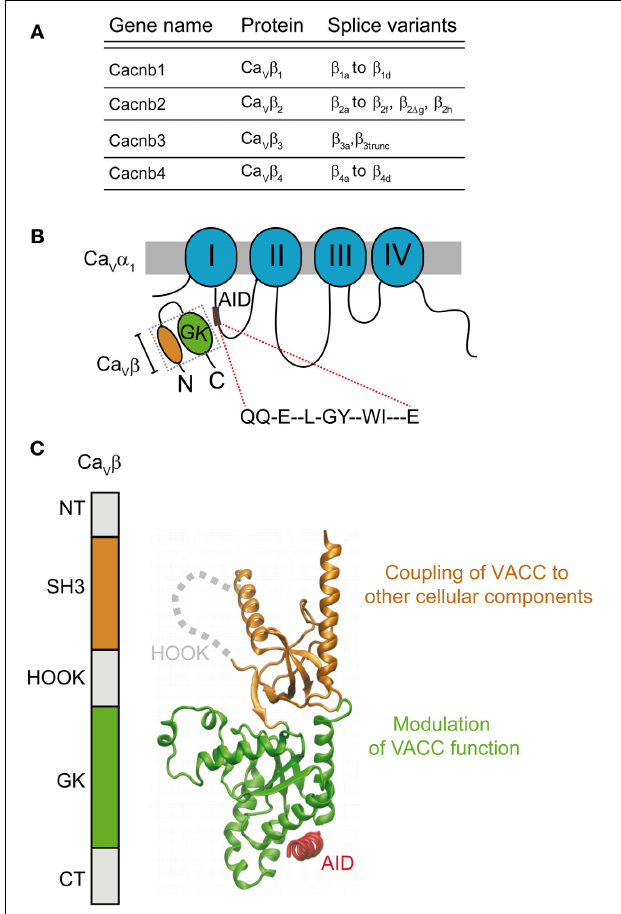
FIGURE 3 | Gene family and structure of the β -subunit. (A) List of β -subunit encoding genes with splice variants (reviewed by Buraei and Yang, 2010). (B) Scheme of the α 1 - and β -subunits showing the consensus amino acid sequence α 1 -interaction domain or AID located within the intracellular I–II loop that binds to the β -subunit guanylate kinase domain (GK). (C) Domain organization and three-dimensional structure (PDB 1T3L) of the β -subunit. The SH3 domain is shown in orange and the GK domain in green. The AID peptide forms an alpha helix (shown in red) upon binding to the GK domain. The GK domain is responsible for modulation of function of HVA channels while SH3 appears to couple the channel to other cellular